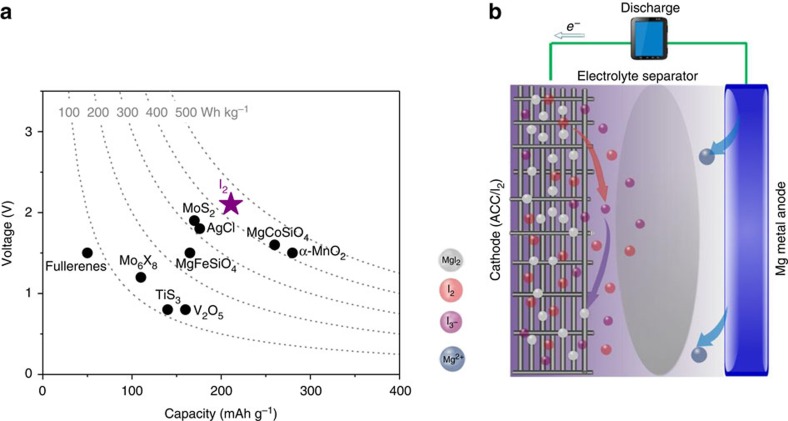
Schematic illustration of the rechargeable magnesium/iodine battery.(a) The capacity and voltage of the iodine cathode compared with reported rechargeable magnesium batteries cathodes. (b) Schematic of rechargeable Mg/I2 batteries.